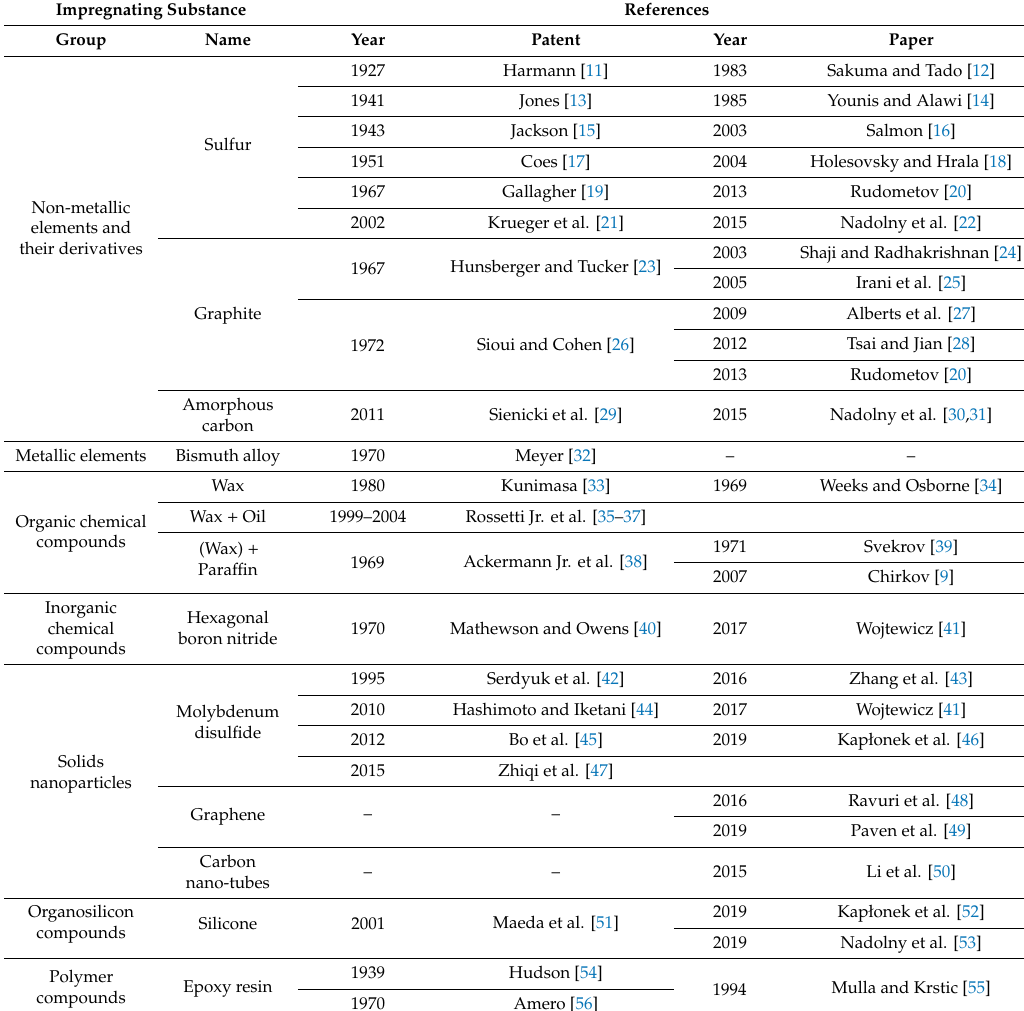
Table 1. Review of selected substances used for the impregnating process of grinding